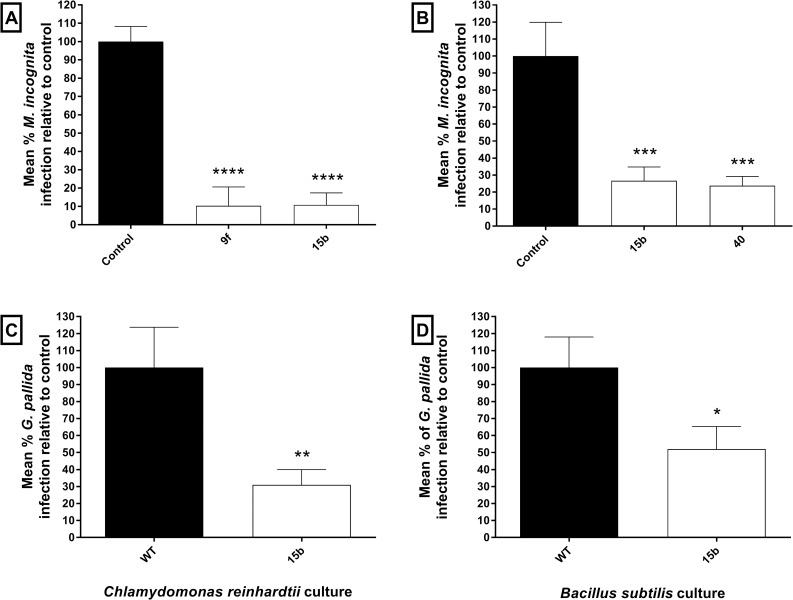
Transgenic microbes secreting uNLPs protect tomato against Meloidogyne incognita and Globodera pallida.(A) Nine independent Chlamydomonas reinhardtii transformants secreting two distinct nematode neuropeptides (Mi-NLP-9f and Mi-NLP-15b) significantly inhibited the ability of M. incognita J2s to infect tomato plants, with up to 90% protection. (B) Bacillus subtilis cultures secreting either Mi-NLP-15b or Mi-NLP-40 also conferred significant protection against M. incognita J2 invasion. (C) C. reinhardtii transformants secreting Gp-NLP-15b (identical to Mi-NLP-15b) significantly inhibited the ability of G. pallida J2s to invade tomato plants. (D) B. subtilis cultures secreting Gp-NLP-15b also protected tomato plants from G. pallida J2 invasion. Data shown represents mean±SEM. *, P<0.05; **, P<0.01; ***, P<0.001 (One-way ANOVA & Fisher’s LSD; Graphpad Prism 6).